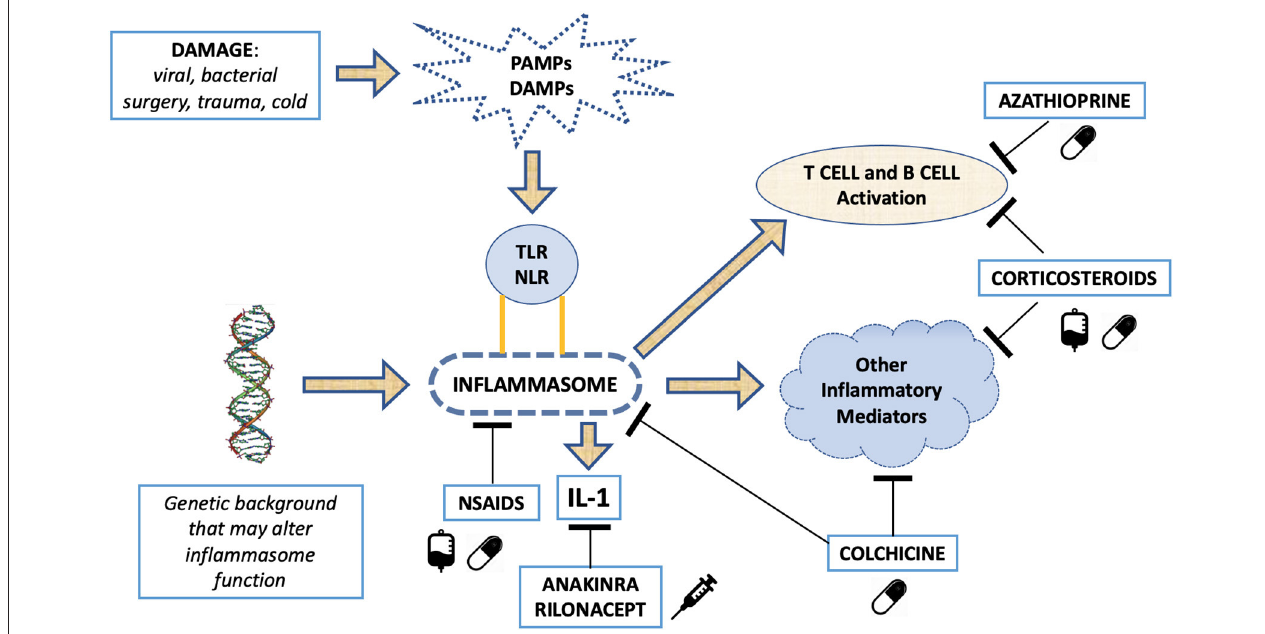
FIGURE 6 | The inflammasome-mediated inflammatory cascade and the location of the effect of currently available drugs for recurrent pericarditis. Non-specific triggers such as structural damage or microbial agents may interact with specific receptors such as NLR and TLR and thus activate the inflammasome. This naturally occurs, but a genetic background may alter the inflammasome response and consequently generate a pathologic response with a sustained inflammatory state. NSAIDs perform their effect directly on inflammasome activation. Azathioprine and corticosteroids carry out their effect mainly on B and T lymphocytes. While Anakinra and Rilonacept directly inhibit IL-1 effects, both colchicine and corticosteroids perform their action on other inflammatory mediators released after inflammasome activation. Furthermore, colchicine also exerts an inhibitory effect on inflammasome activation. PAMPs, pathogen-associated molecular patterns; DAMPs, damage-associated molecular patterns; TLR, toll-like receptor; NLR, NOD-like Receptor; NSAIDs, non-steroidal antiinflammatory